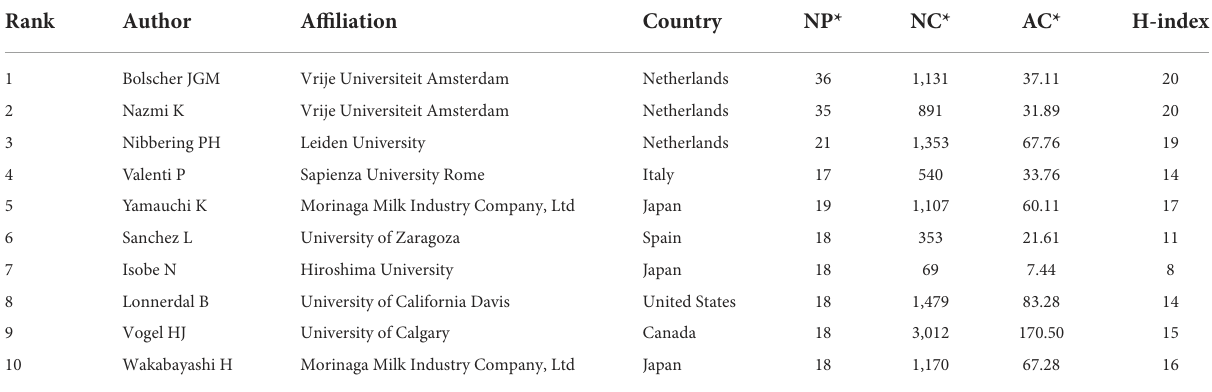
TABLE 3 Top 10 active authors in the field of LF antibacterial